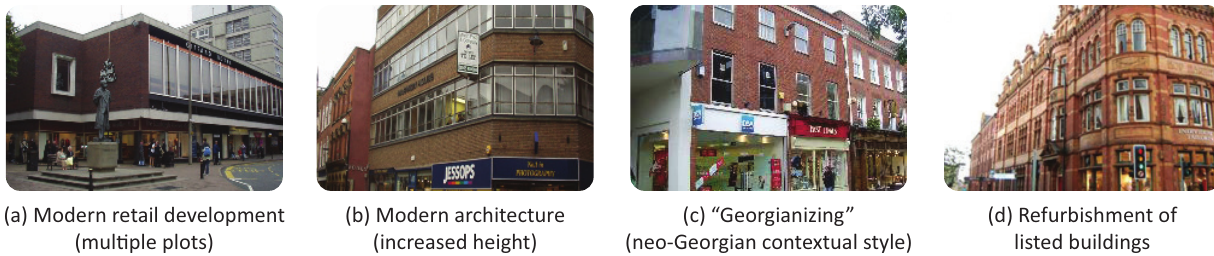
Figure 2. Examples of Modern 1960s retail‐led developments (a and b) and later contextual style schemes (c) and listed building refurbishment (d). Photos by the